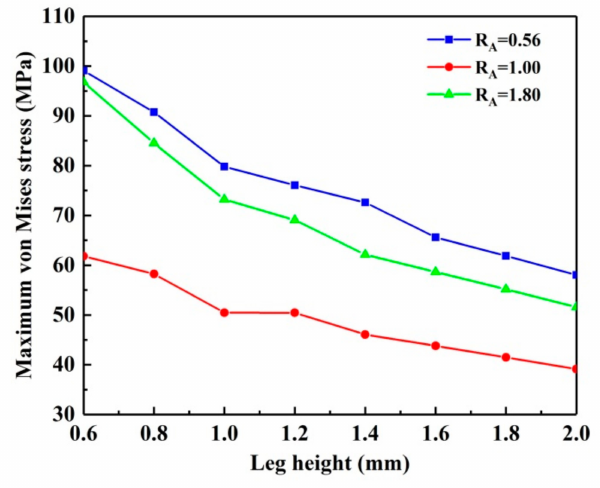
Figure 11. Change of the maximum von Mises stress with leg height for different R A .